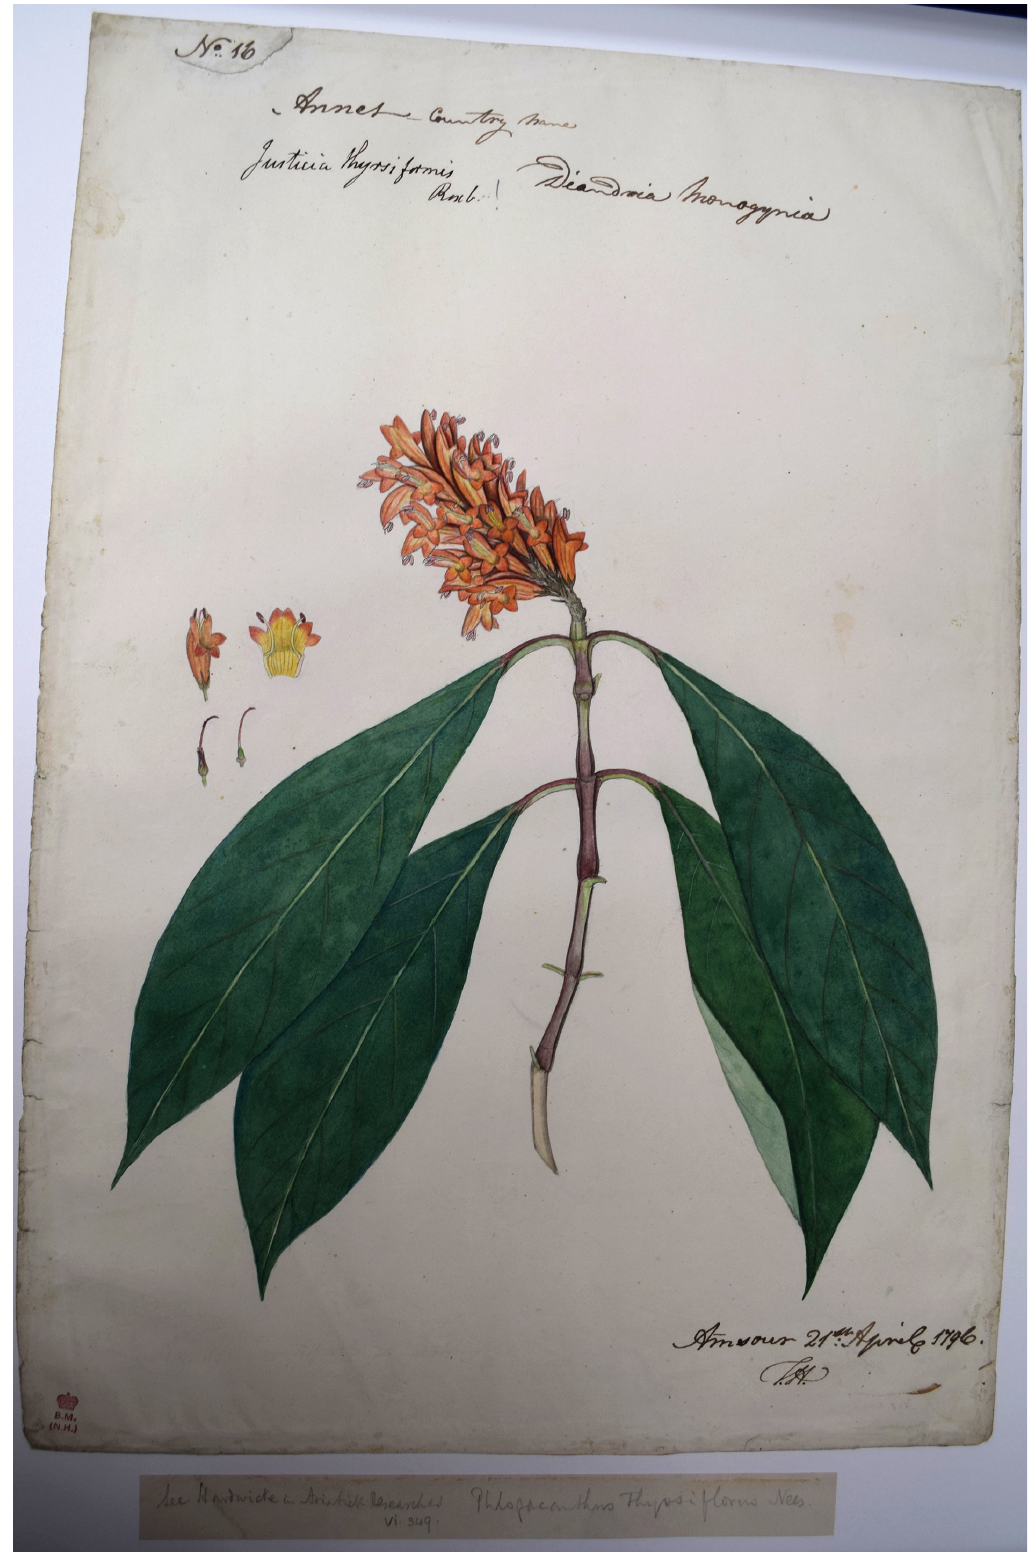
Fig. 1. Lectotype of Justicia thyrsiformis Roxb. ex Hardw., Hardwicke Drawing no. 16 from the collection of the Botany Library, Natural History Museum. © The Natural History Museum,